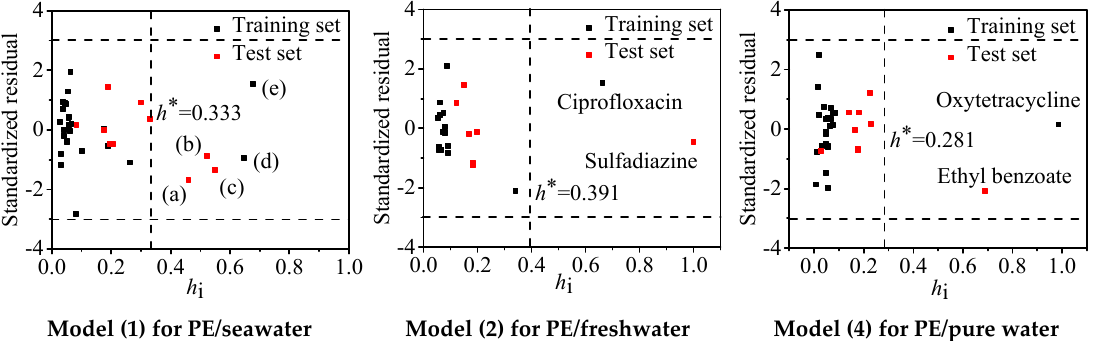
Figure 3. Williams plots for the applicability domain of Models (1), (2), and (4). The h i refers to the verse leverage value. (a): δ -hexachlorocyclohexane, (b): α -hexachlorocyclohexane, (c): pentachlorobenzene, (d): dioctyl phthalate, (e): oxytetracycline.